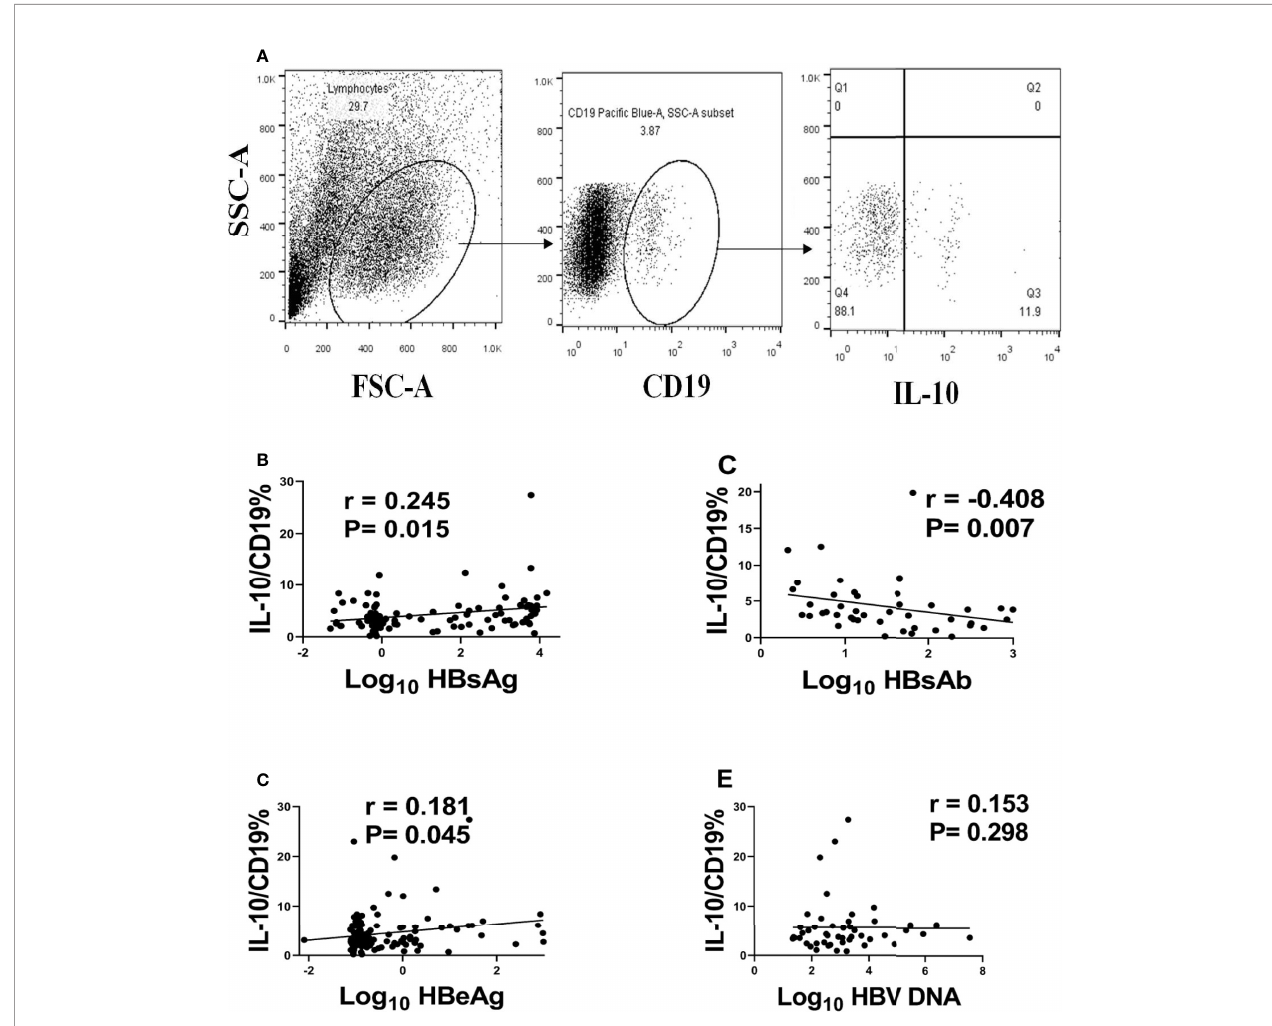
FIGURE 1 | B10 positively associated with HBsAg and HBeAg and negatively associated with anti-HBs. We de fi ned B10 as the level of IL-10 in CD19+ cells (A) and analyzed the relationship of B10 with HBsAg (B) , anti-HBs (C) , HBeAg (D) and HBV DNA (E)